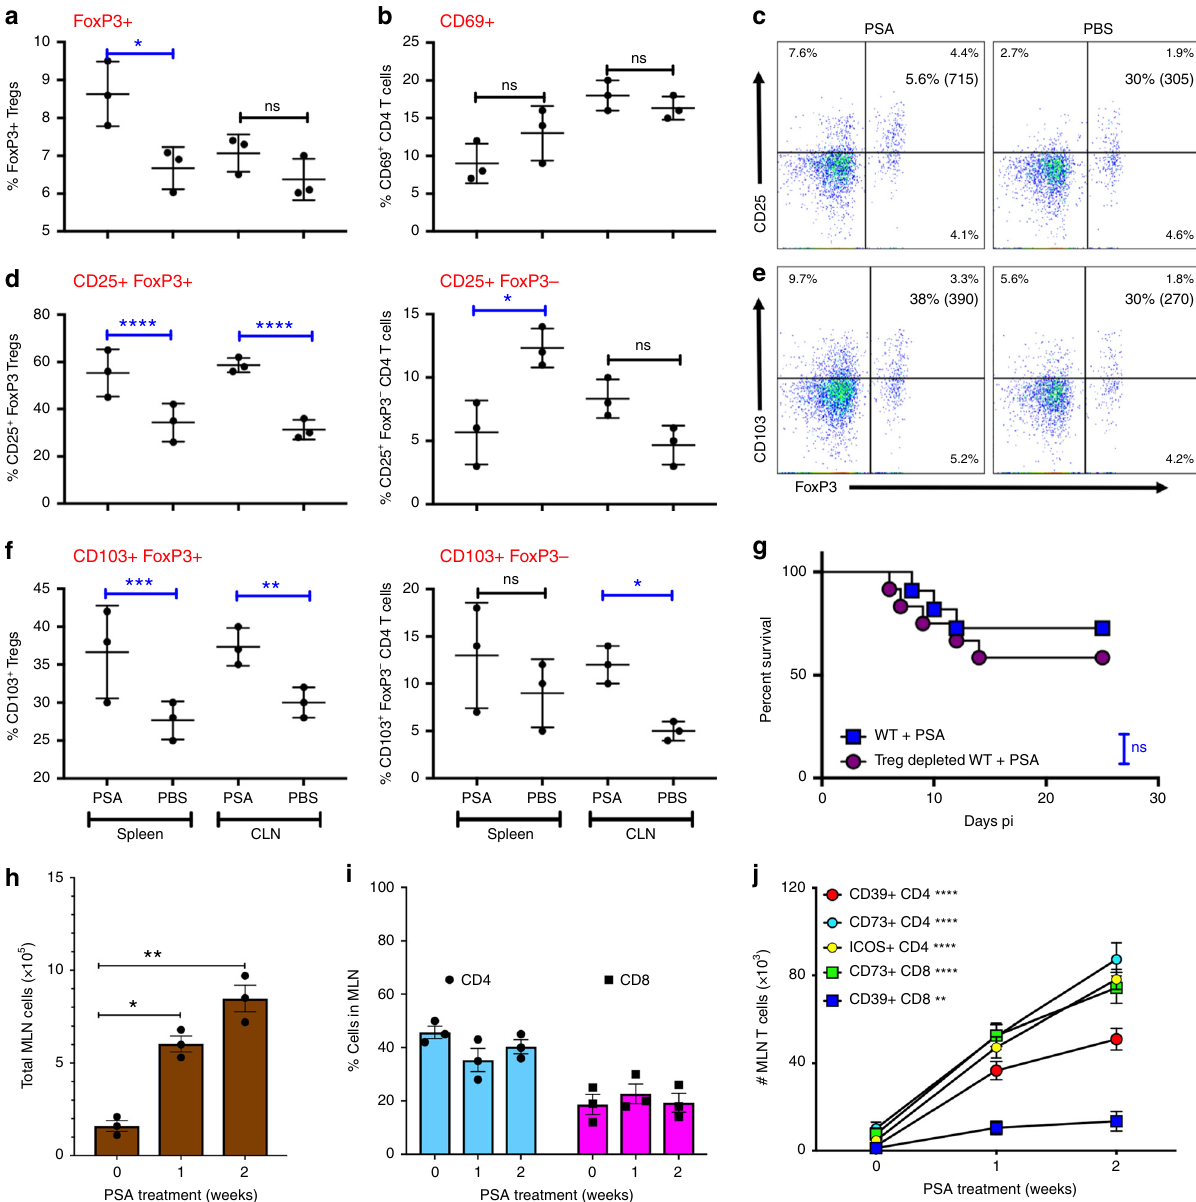
Fig. 3 PSA protection from HSE is independent of induced Tregs. a % FoxP3 + CD4 Tregs and b CD69 + CD4 T cells in spleen and CLN of PSA or PBS- treated WT mice at day 6 pi. c CD25 expression within FoxP3 + CD4 Tregs in WT mice at day 6 pi, % and mean fl uorescence intensity (MFI) in () shown in right top quadrant. d % CD25 within FoxP3 + Tregs (left plot) and FoxP3 − CD4 + T cells (right plot), e CD103 expression within FoxP3 + Tregs in WT mice at day 6 pi; % and MFI in () shown in right top quadrant. f CD103 within FoxP3 + Tregs (left plot) and FoxP3 − CD4 + T cells (right plot) in the spleen or CLN of WT mice at day 6 pi. Data from three experiments shown. g PSA-treated Treg depleted and control WT mice were monitored for survival after HSV infection and ACV treatment as in Fig. 1a, ns: not signi fi cant determined by log rank Mantel – Cox test ( n = 11 – 12 mice). After administration of three (1 week) or six doses (2 weeks) of PSA, MLN in uninfected WT mice were monitored for h cellularity, i % CD4 and CD8 T cells, and j # ICOS + , CD39 + , and CD73 + CD4 and CD8 T cells ( n = 3 mice); **** p < 0.0001, ** p < 0.01 as determined by two-way ANOVA or one-way ANOVA with Sidaks or Turkeys correction, respectively, for multiple comparisons tests. All data show mean ± SEM groups of Rag − / − recipients were treated with six doses of PSA or Rag − / − recipients of IL10KO B cell and WT T cells was aug- PBS, infected with HSV and then treated with ACV according to mented (~50%), this was not statistically signi fi cant (Fig. 5c). the scheme in Fig. 5a. Recapitulating results obtained with WT Analysis of BS in fi ltrates in all four groups of mice revealed that and IL-10KO mice, PSA but not PBS-treated Rag − / − recipients of only Rag − / − mice that received WT T and B cells had reduced WT B and T cells were protected from subsequent HSV chal- CD45 high in fi ltrates in the BS, whereas all other groups of Rag − / − recipients exhibited high levels of in fl ammation characterized by lenge, while Rag − / − recipients of IL-10KO B and T cells suc- cumbed to fatal HSE (Figs. 1b, 4c, 5c and Supplementary Fig. 1e). CD45 high cells comprised predominantly of either CD11b + CCR2 + Ly6C high IM or CD11b + Ly6G + PMN (Fig. 5d, e and Most of the mixed transfer recipients of WT B cell and IL-10KO Supplementary Fig. 5c). Since Rag recipients of donor WT or T cell subsets also succumbed to HSE. Although, protection of NATURE COMMUNICATIONS| (2019) 10:2153